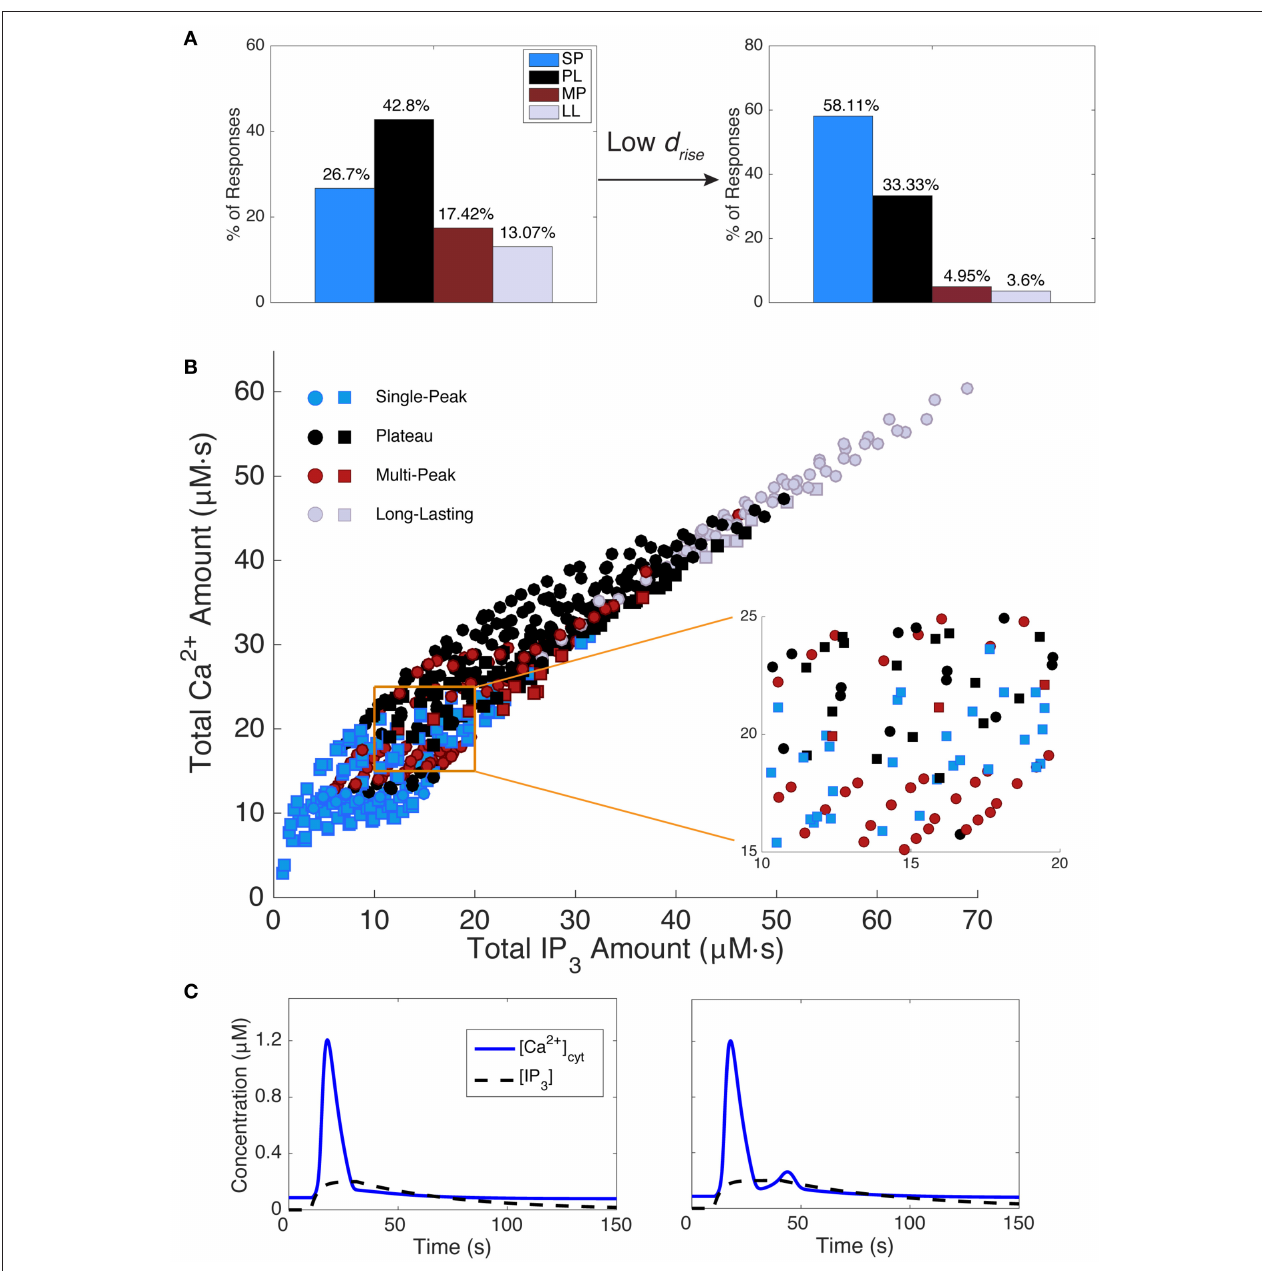
FIGURE 5 | Effect of IP 3 kinetics on Ca 2 + responses. (A) The left histogram shows the distribution of model response types while scanning IP 3 kinetics over the full parameter range from Table 1 . The right histogram plots the response type distribution for shorter IP 3 rise durations ( d rise < 22s). Shorter IP 3 rise durations tend to decrease the occurrence of mostly MP and LL responses, with SP being the major response type, while longer IP 3 rise durations decrease the percentage of SP responses, but increase other response types. (B) The total IP 3 amount correlates with the total Ca 2 + amount. However, in most regimes, within a small range of IP 3 (and Ca 2 + ) amounts, a mixture of Ca 2 + response types are generated. An example of such a regime is shown in the zoomed section. Squares indicate responses generated with d rise < 22s (corresponding to data set in the right histogram in (A) and circles indicate responses generated with all other d rise values from Table 1 . (C) Two example Ca 2 + responses are shown with their underlying IP 3 dynamics. As seen, a small change in IP 3 kinetics is sufficient to change the Ca 2 + response type from SP to MP, while the total IP 3 amount remains roughly the same (15.28 and 15.17 µ M, respectively; Ca 2 + amounts are 13.86 and 15.56 µ M, respectively). IP 3 parameters ( A , d rise , r rise , d dec ): 0.2, 21, 0.3, 220 (SP), 0.2, 31, 0.3, 179